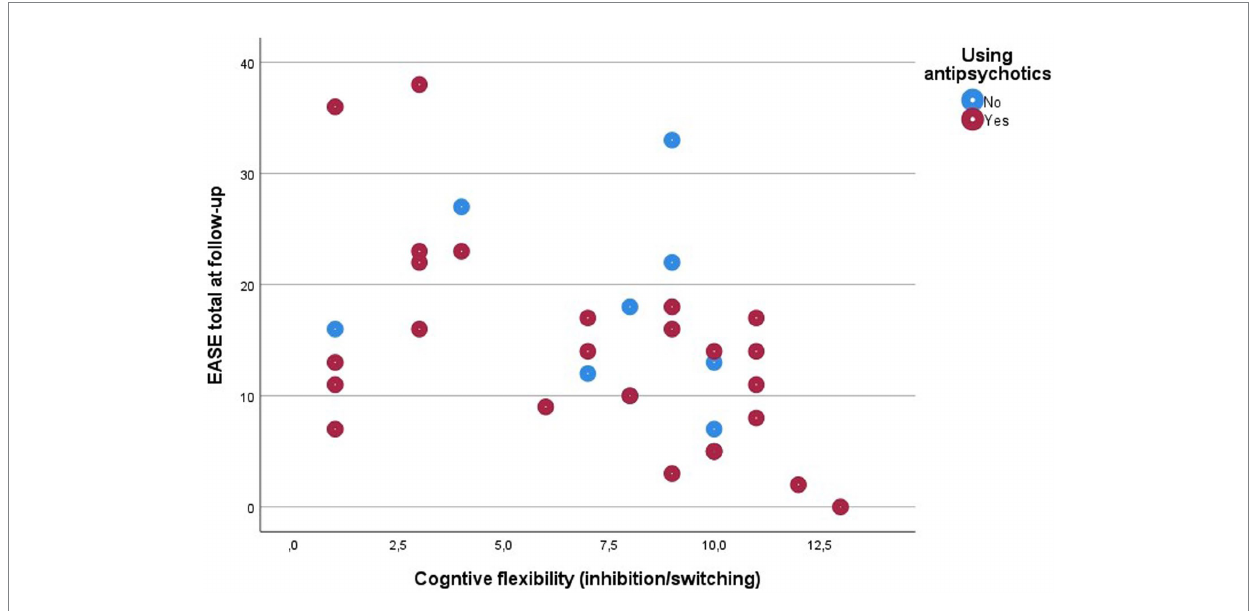
FIGURE 2 Scatter plot of associations between cognitive flexibility and